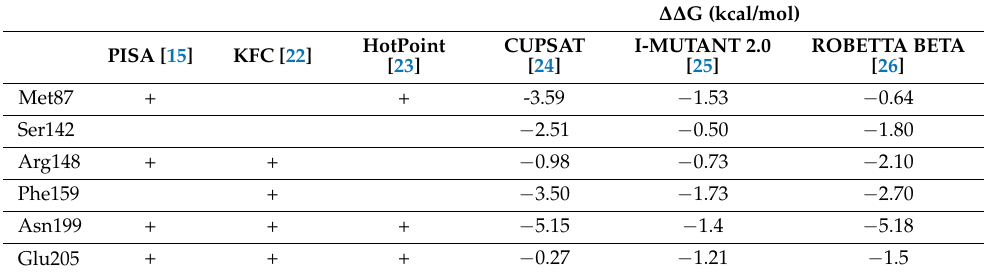
Table 1. The results of the hot spot analysis (the residues selected as hot spots by the servers are marked with the “plus” sign) and free energy change predicted by the alanine scanning approach (the “minus” sign denotes a destabilizing effect on the monomer–monomer interface upon mutation). ∆∆ G (kcal/mol) HotPoint CUPSAT PISA [15] KFC [22] [23] [24] Ser142